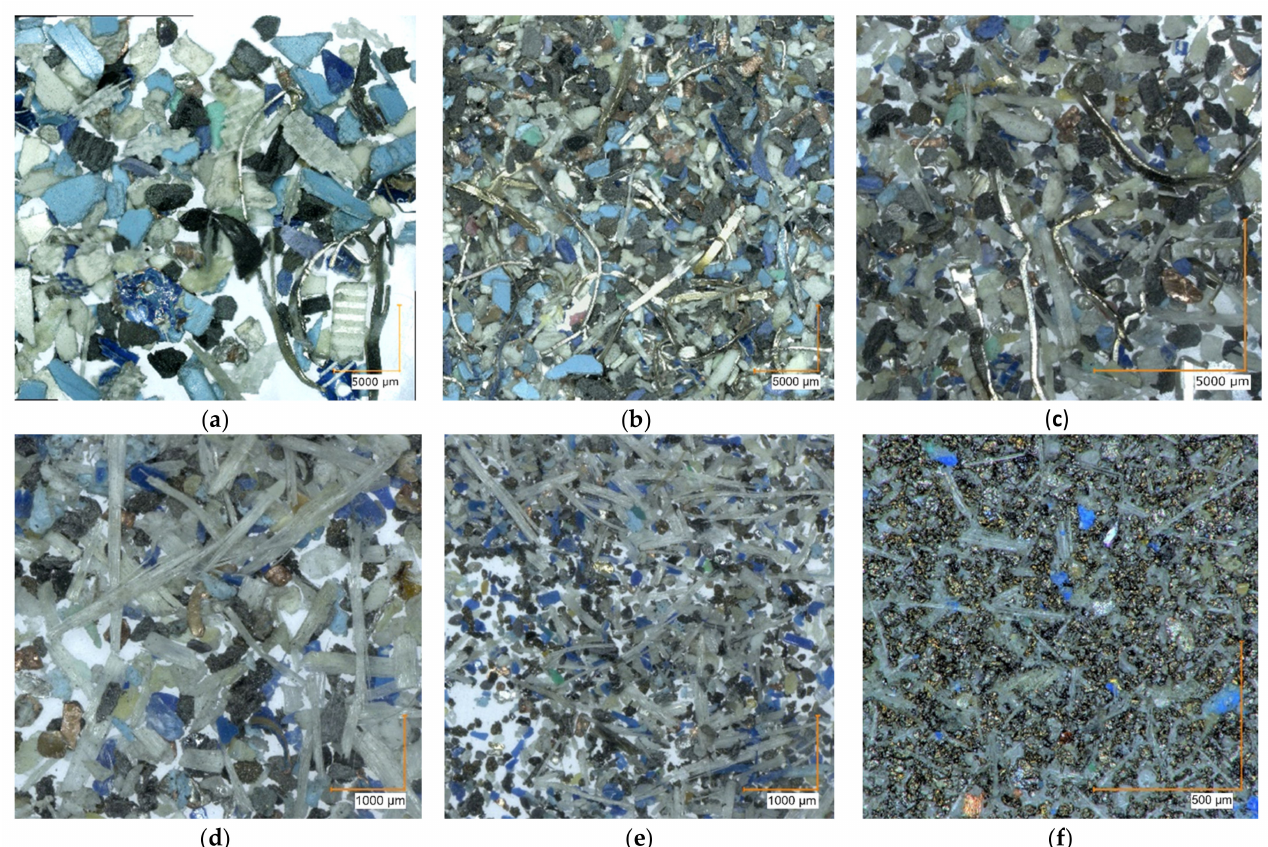
Figure 5. Optical images of the fractions 1.4–2.8 mm ( a ), 0.711–1.4 mm ( b ), 0.355–0.711 mm ( c ), 0.355–0.18 mm ( d ), 0.09–0.18 mm ( e ) and <0.09 mm with significantly lower fiberglass